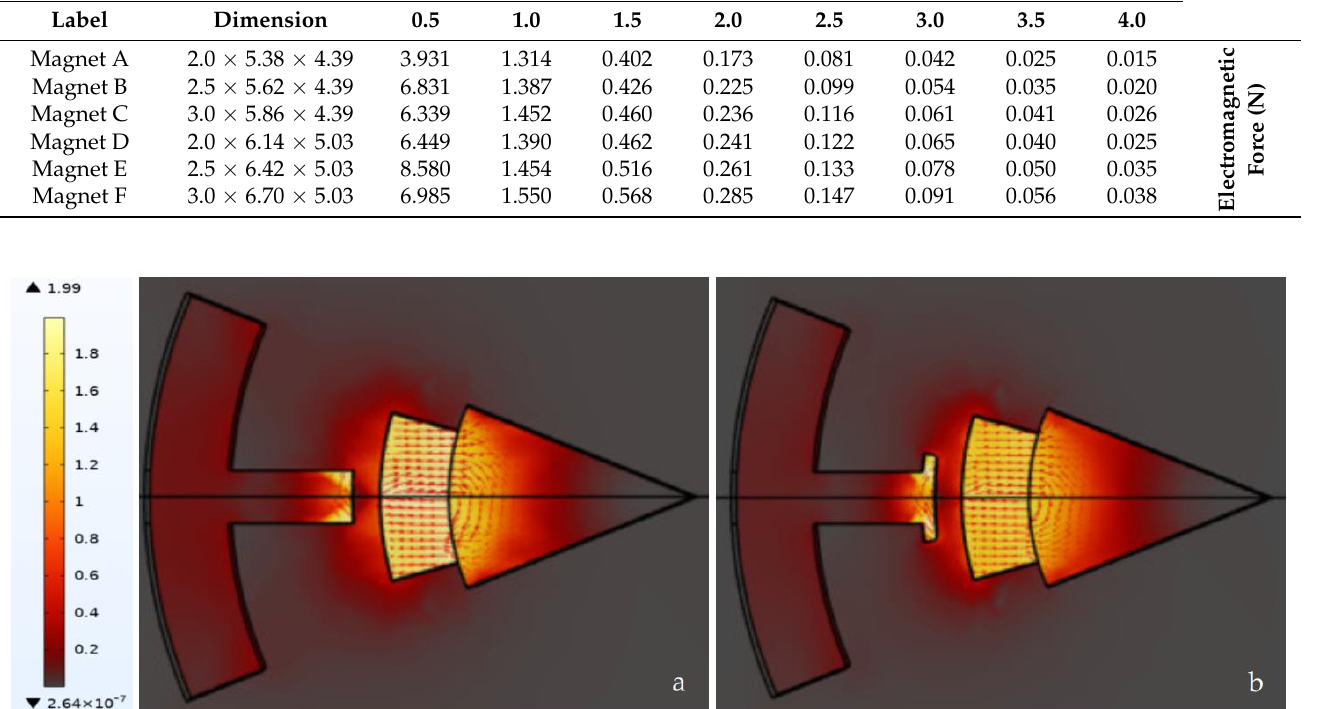
Figure 5. Electromagnetic force strength. ( a ) Square edge stator. ( b ) T shape stator. The electromagnetic force strength towards the stator iron is highly influenced by the dimension of the magnet, magnetic properties, and air gap thickness as shown in Table 2.